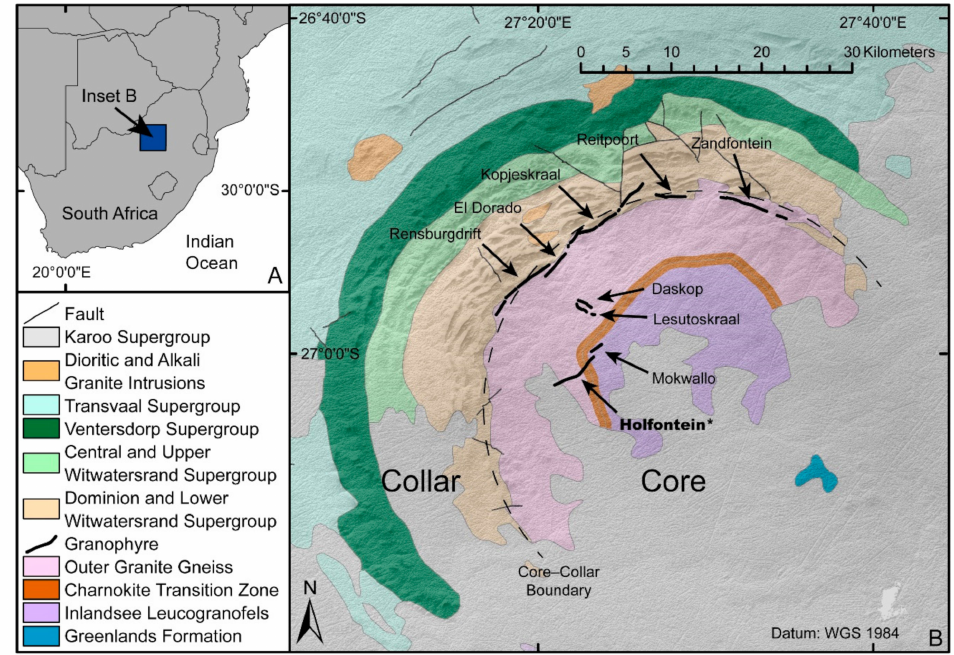
Figure 1. Generalized geological map of the Vredefort Impact Structure. ( A ) Location of the Vredefort Impact Structure in South Africa. ( B ) Surface geology and prominent structures associated with the Vredefort Impact Structure. The stratigraphy and structure from the South African Council for Geosciences, granophyre dikes locations according to [3]. The studied dike is indicated by *. The topography is generated from the Advanced Spaceborne Thermal Emission and Reflection Radiometer Global Digital Elevation Map (ASTER GDEM). ASTER GDEM is a product of the Ministry of Economy, Trade, and Industry (METI) of Japan and the United States National Aeronautics and Space Administration